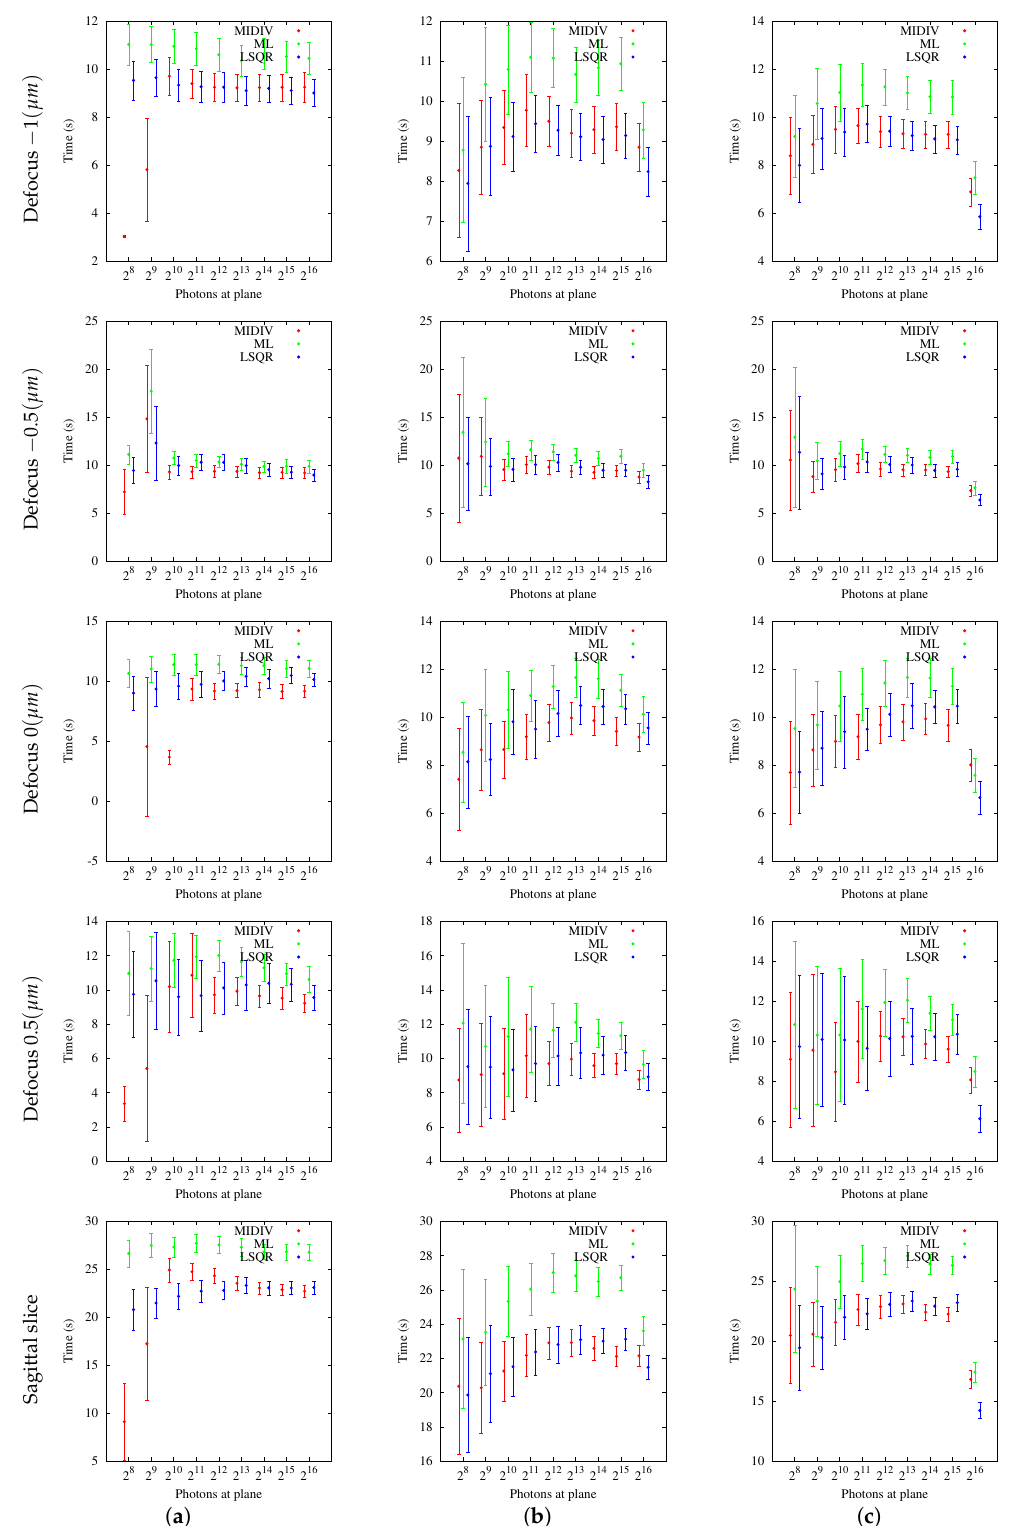
Figure 7. Time measurements of the methods: MIDIV (red), ML (green) and LSQR (blue). Results are presented as the mean point estimates of the total computing times per parameter estimation and their confidence intervals. ( a ) NCI; ( b ) NCII; ( c )